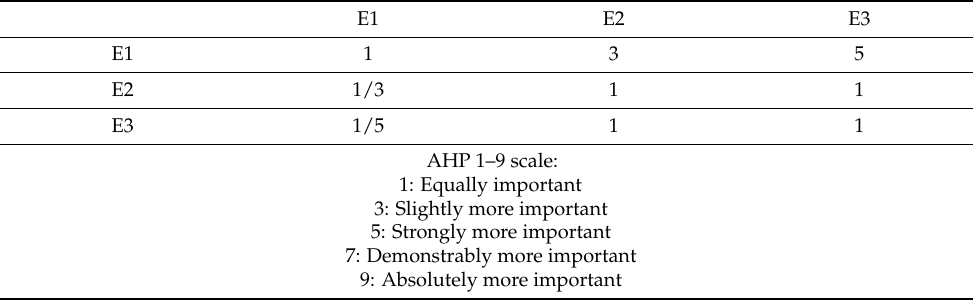
Table A1. Comparison matrix for economic factors from Expert